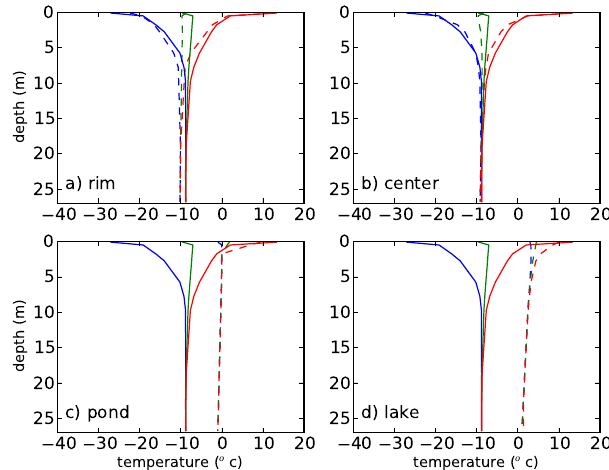
Figure 10. Simulated soil freezing (blue) and thawing (red) fronts, Figure 11. Comparisons between simulated (dashed lines) and mea- and water freezing (green) and thawing (yellow) fronts (depths in sured (solid lines) values for annual mean (green), maximum (red), meters) over the period from 2003 to 2011 for (a) the rim site, and minimum (blue) soil temperatures ( ◦ C) averaged over the pe- (b) the center site, (c) the pond site with 20cm maximum snow riod from 2007 to 2011 for the (a) rim, (b) center, (c) pond, and thickness, (d) the pond site with 2cm maximum snow thickness, (d) lake and (e) the lake site. The surface of the soil was taken to be at 0m depth, with the downward direction positive and the upward direc- tion negative. Table 6. The simulated multiyear mean (2003–2011) unfrozen soil thicknesses (m)/soil temperature ( ◦ C) for 26.75m depth at the lake site, using different combinations of eddy diffusivities (ke; 1, 10, and 100 indicate the multiplication factor applied to the original value) and equilibrium runtime. ke1 ke10 ke100 2000yr 31.71 / 0.40 33.84 / 0.55 34.35 / 0.60 3000yr 41.07 / 1.03 43.28 / 1.08 43.85 / 1.08 4000yr 49.62 / 1.50 52.37 / 1.50 53.02 / 1.50